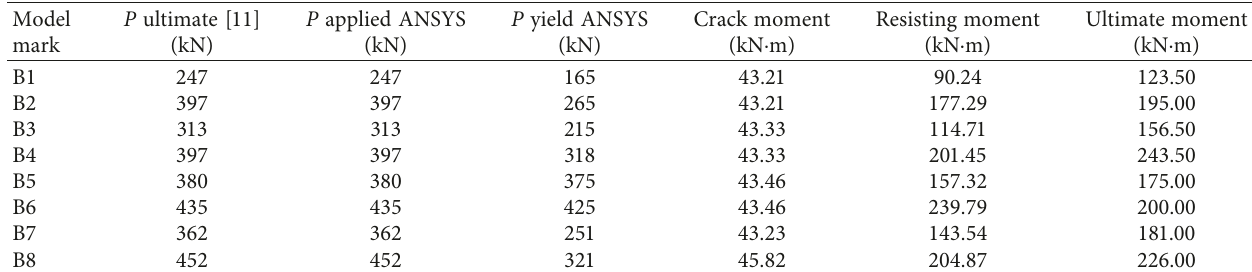
Table 7: Load stages, crack moment, resisting moment, and ultimate moment.